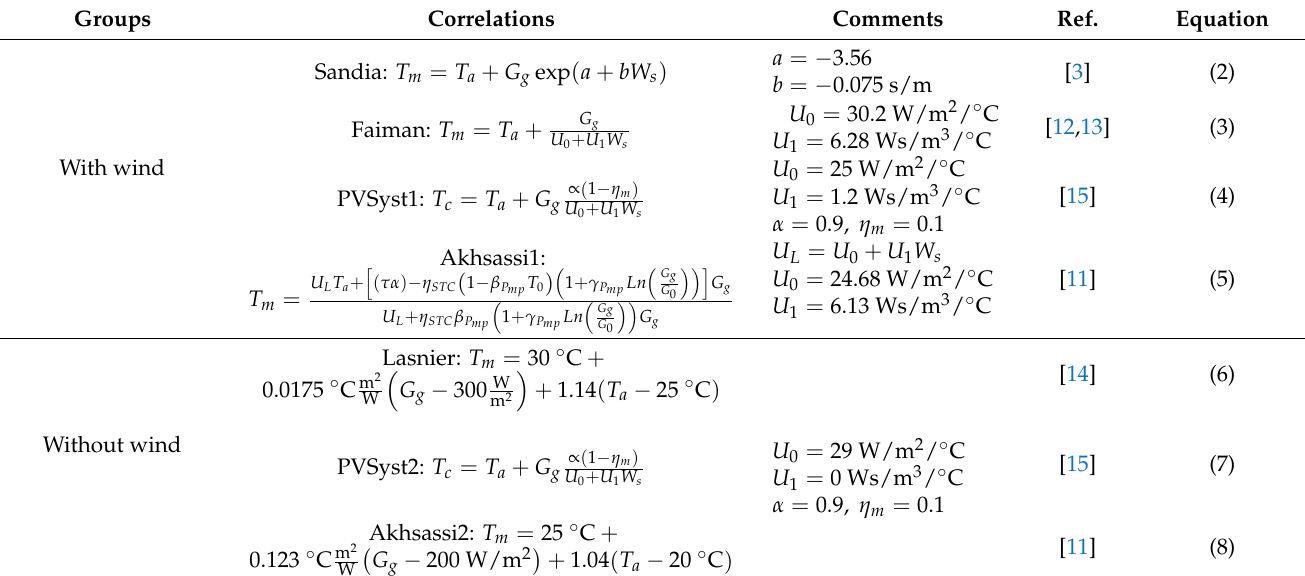
Table 3. Literature models for validating proposed